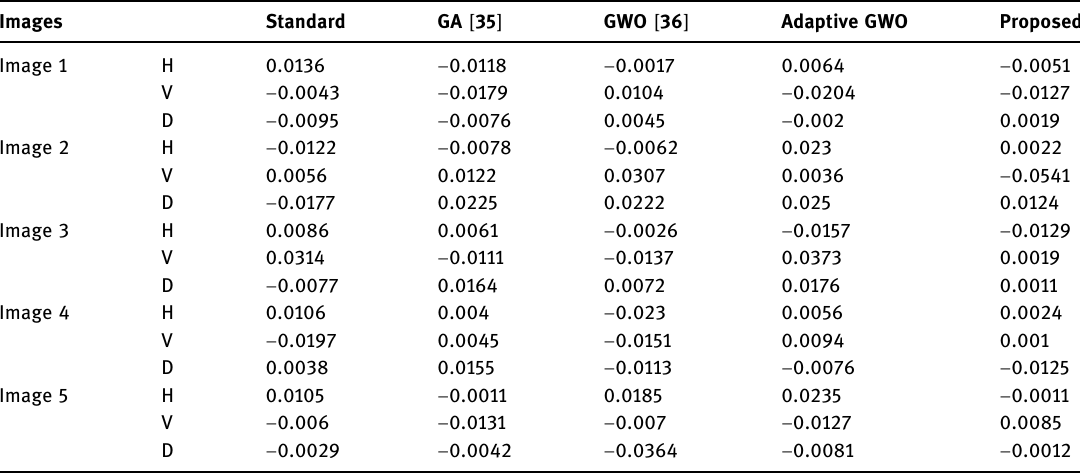
Table 4: Autocorrelation analysis of adjacent pixels by using MRI images Images